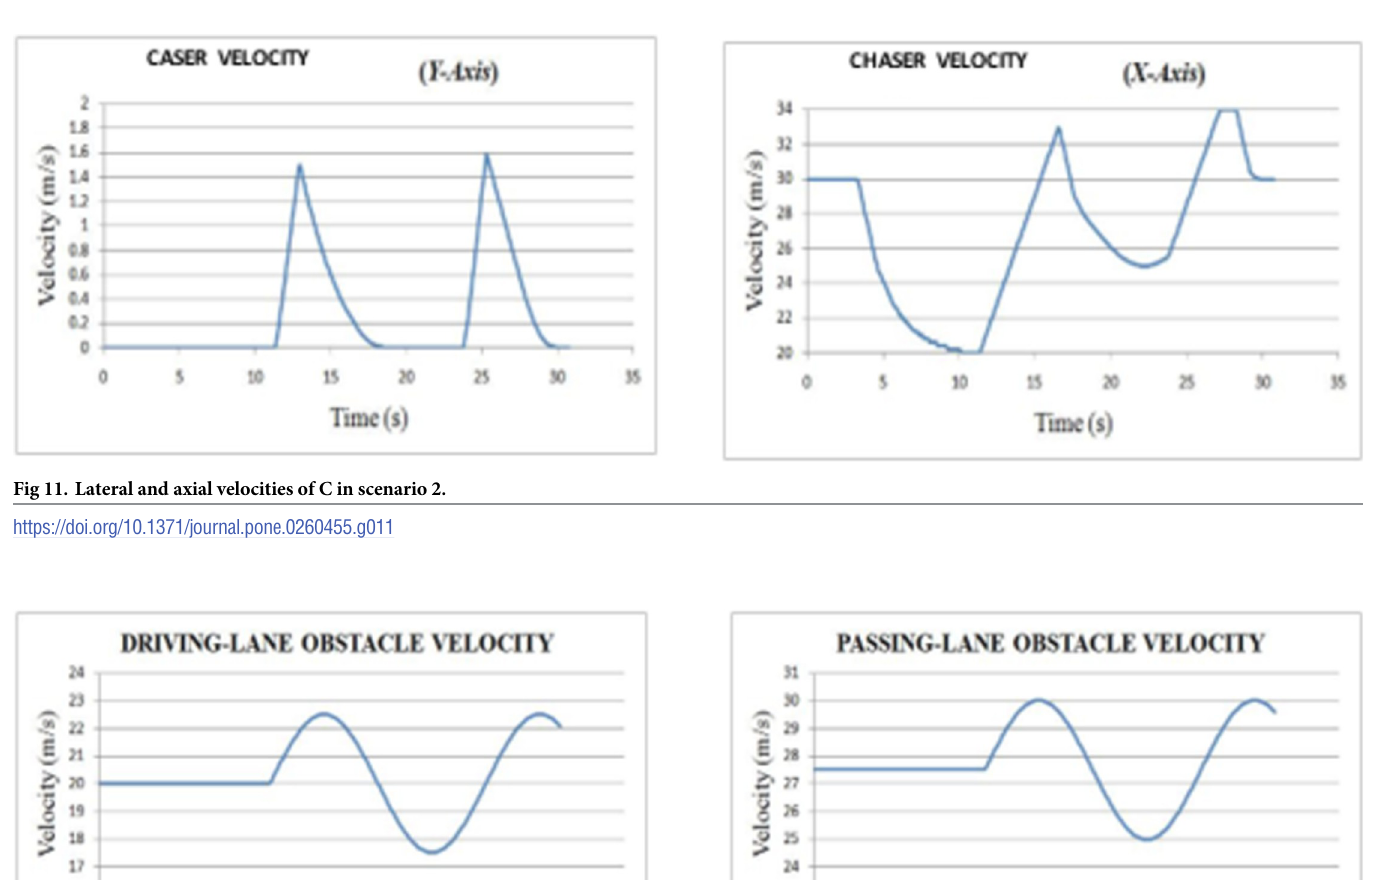
PLOS ONE | https://doi.org/10.1371/journal.pone.0260455 January 20,